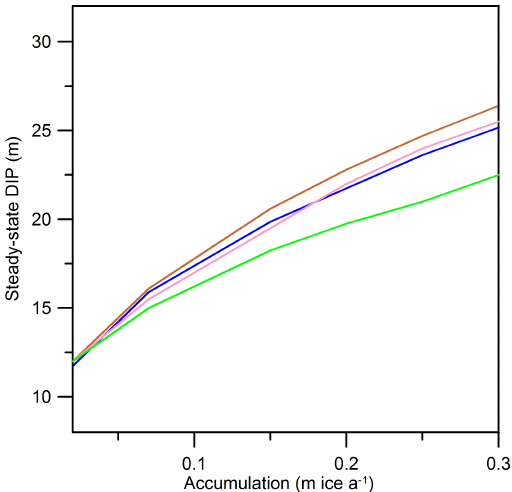
Figure 11. Variation of steady-state DIP with ¯ a using the Herron and Langway (brown line), Ligtenberg (green line), Simonsen (pink line) and transition (blue line) models. Simonsen and Ligtenberg results are taken from